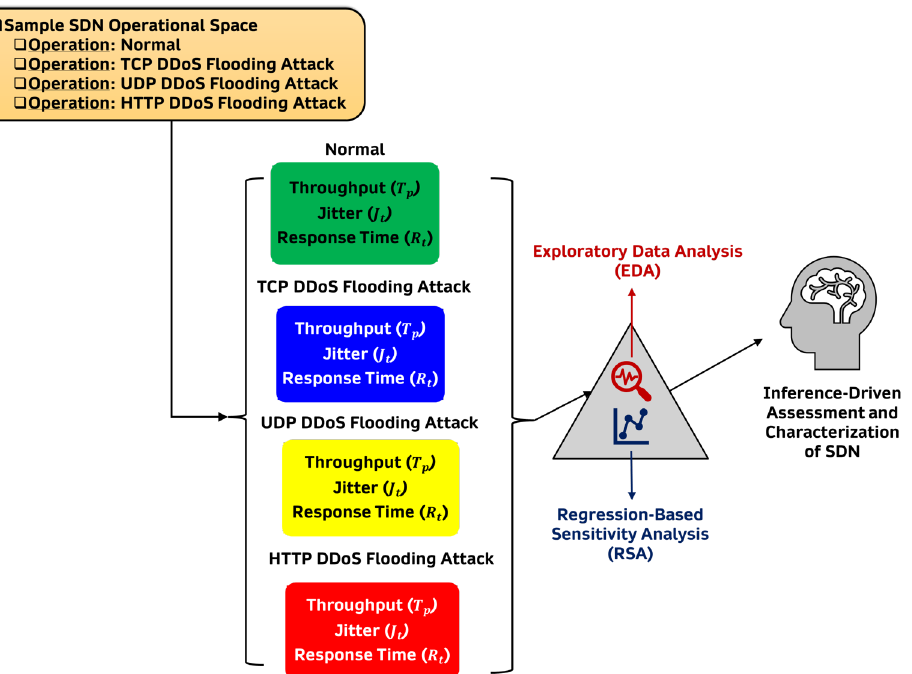
Figure 3. Flow diagram of the proposed behavioral study